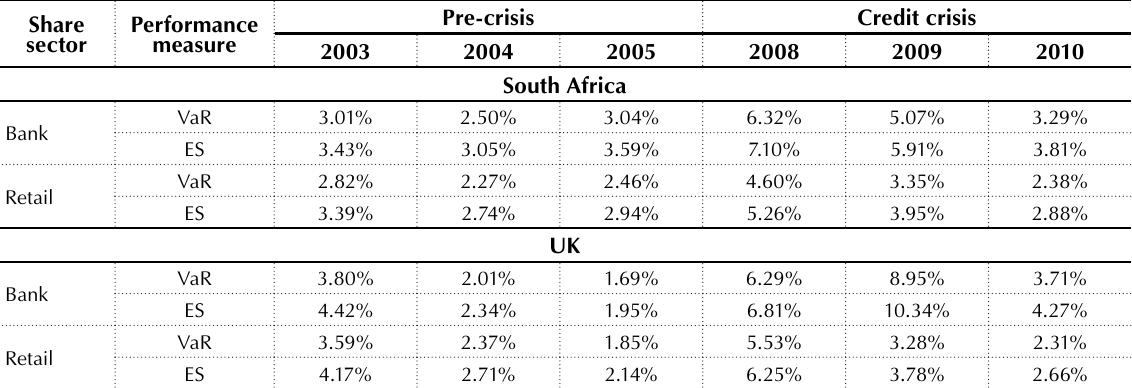
Source: Authors’ calculations.